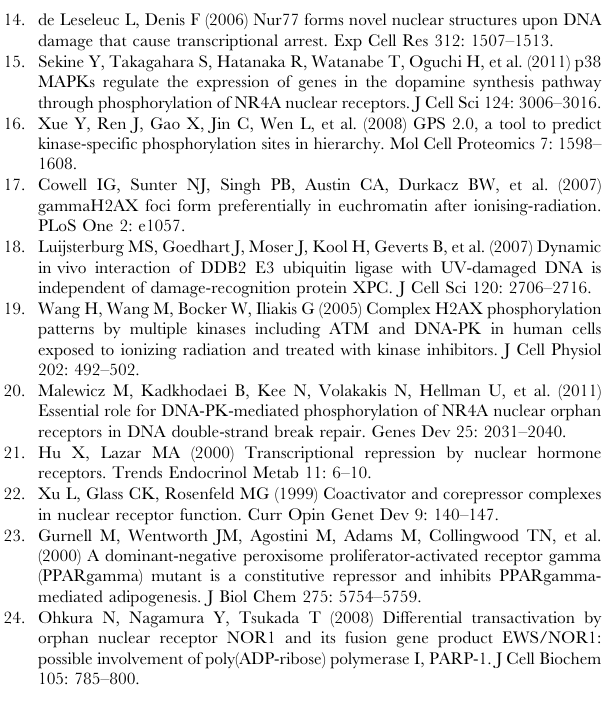
Figure S1 NR4A2- PPAR c dom neg chimera, N2-DS, is recruited to nuclear foci but fails to localise with DNA repair proteins. ( A–C ) MM96L cells transfected with WT NR4A2 or the N2-DS chimera were treated with 25 mJ/cm2 UV, fixed at 4 hours post-UV treatment. Immunofluorescence was performed to detect ( A ) c H2A.X; ( B ) DDB2; and ( C ) XPC proteins. Left panels (green fluorescence), pEYFP-NR4A-WT (upper) or pEYFP-N2-DS (lower); Middle panels, c H2A.X, DDB2 or XPC immunofluorescence (red); Right panels, merged images; Representative images from 4 independent experiments is shown. Figure S2 Trichostatin A (TSA) treatment restores co- localisation of N2-DS chimera and DNA repair proteins. The co-localisation of the N2-DS chimera (green) and ( A ) c H2A.X, ( B ) DDB2 or ( C ) XPC shown in red was performed in the presence of vehicle (upper panels) or TSA (lower panel). These